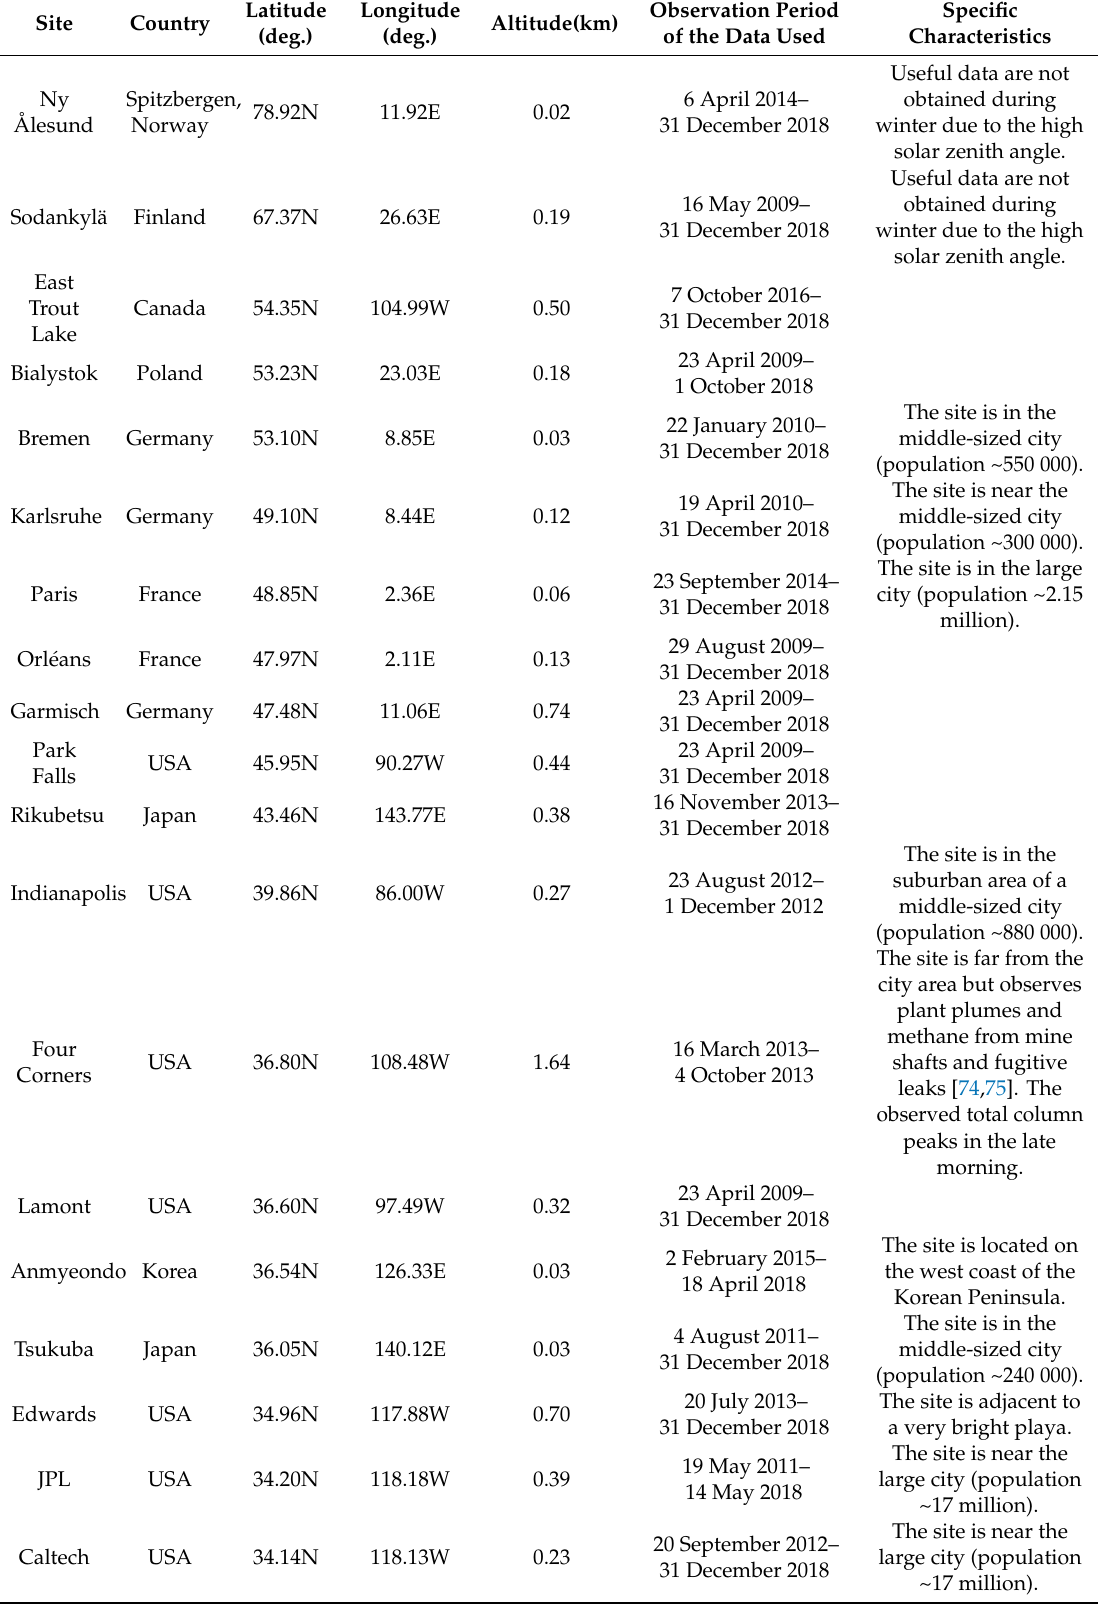
Table A1. Overview of the TCCON sites